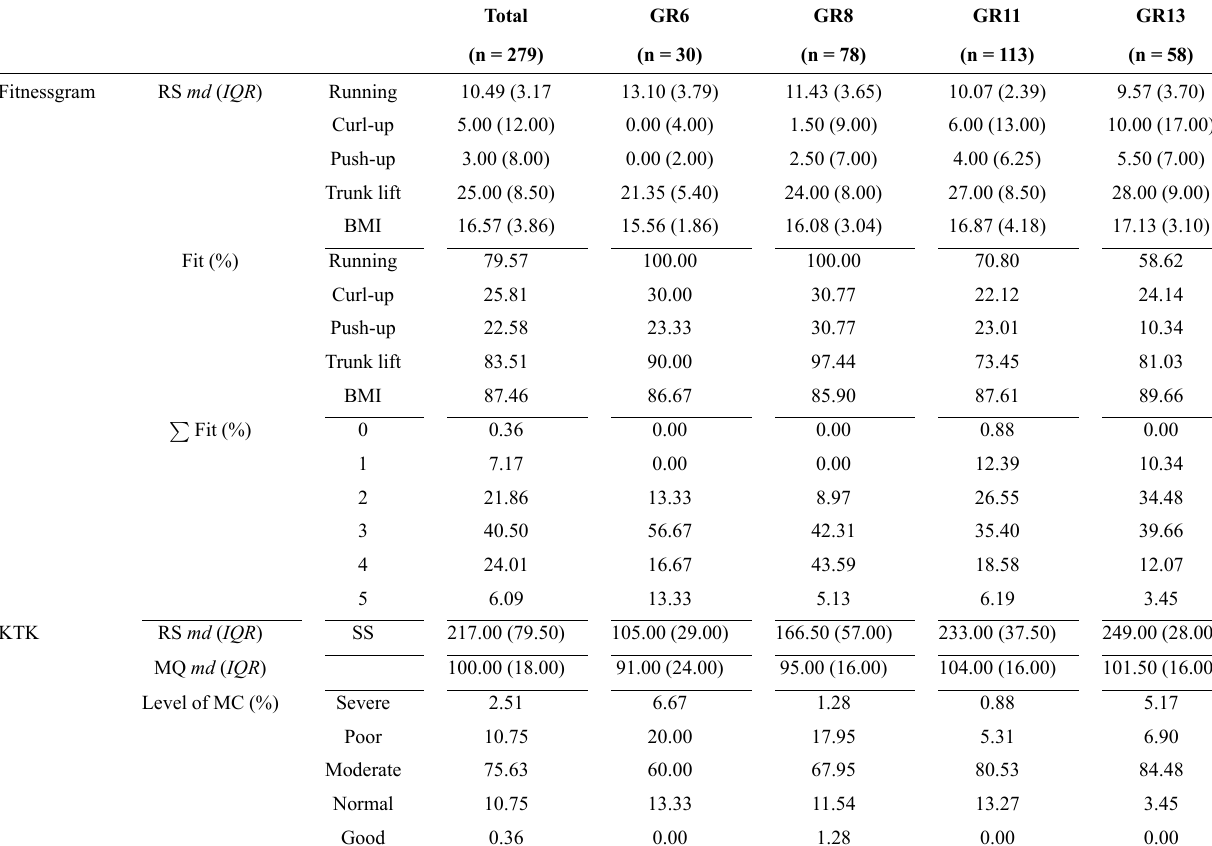
Table 3 - Boys sample characteristics. Raw scores for Fitnessgram and KTK, percentage of subjects rated as fit (Fit) and the sum ( test; Motor Quotient and Level of Motor